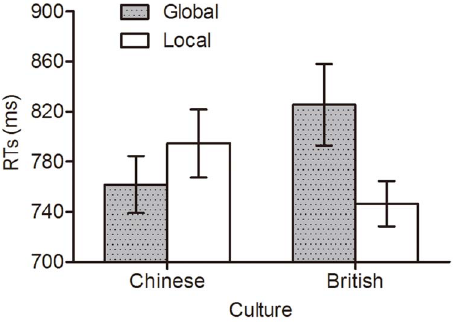
Figure 4. Mean reaction times (RTs) in session 1 in each group. Error bars depict standard errors.